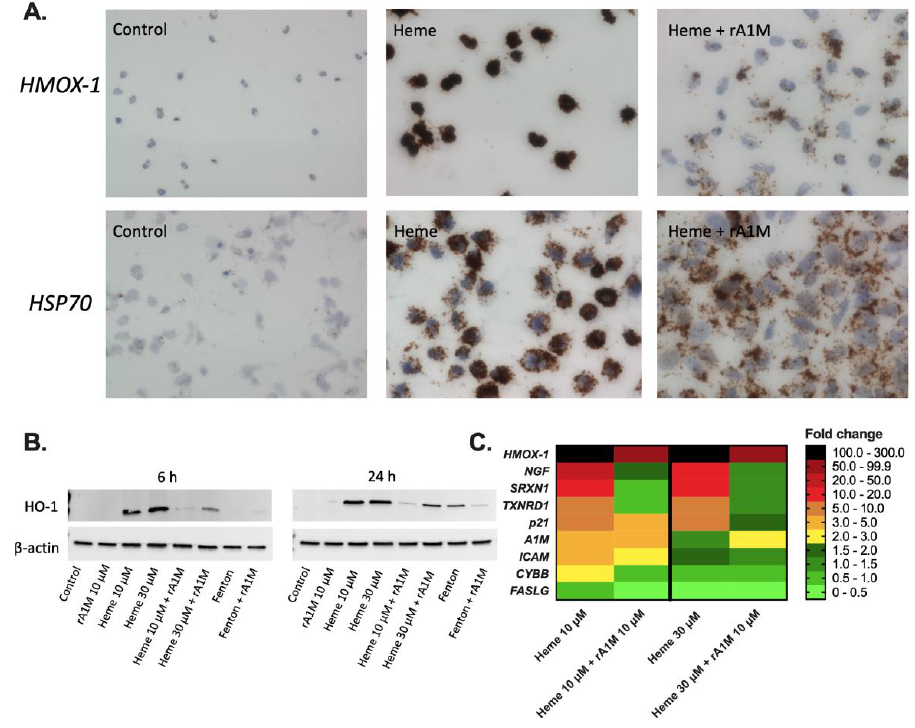
Figure 2. rA1M counteracts induction of stress and apoptosis in HK-2 cells. Representative